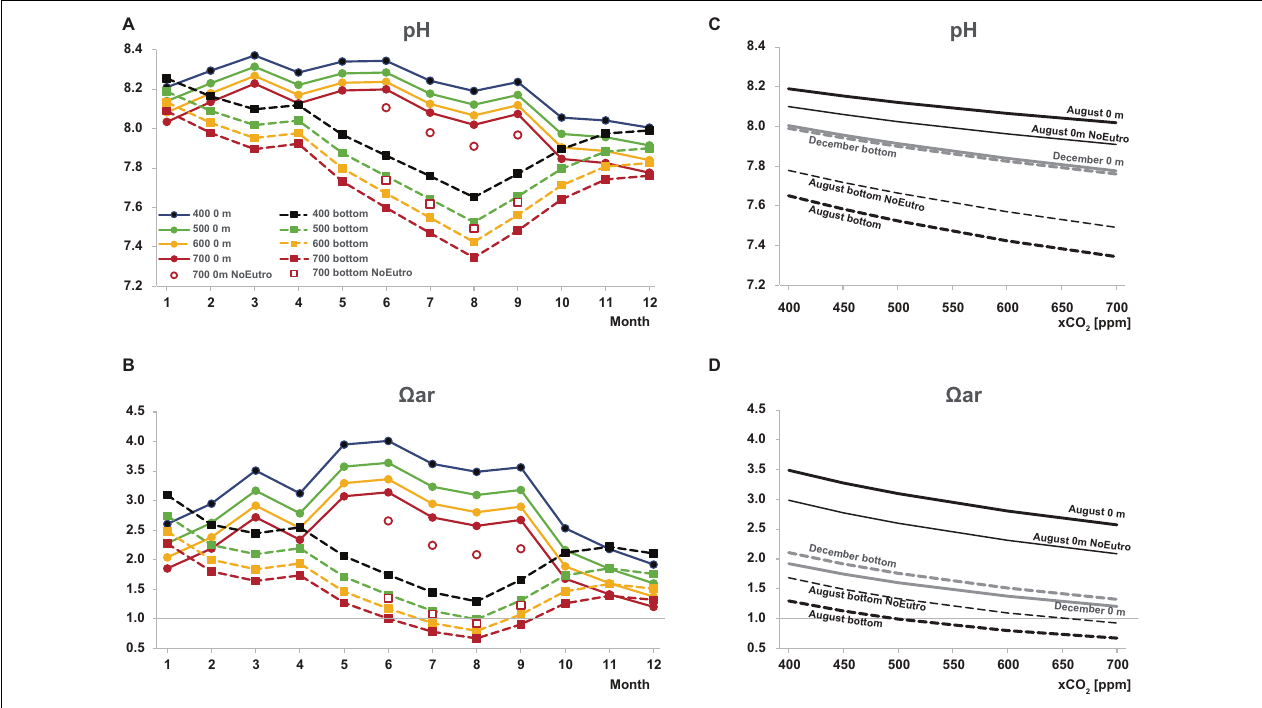
FIGURE 7 | Predicted changes in (A,C) pH and (B,D) (cid:127) ar in the surface (solid lines) and the bottom (dashed lines) waters with increasing atmospheric xCO 2 . (A,B) Show seasonal variations. (C,D) Indicate future progress of ocean acidification in August (black lines) and December (gray lines). Estimated pH and (cid:127) ar values in the absence of eutrophication are indicated as open symbols (A,B) or thin lines (C,D)